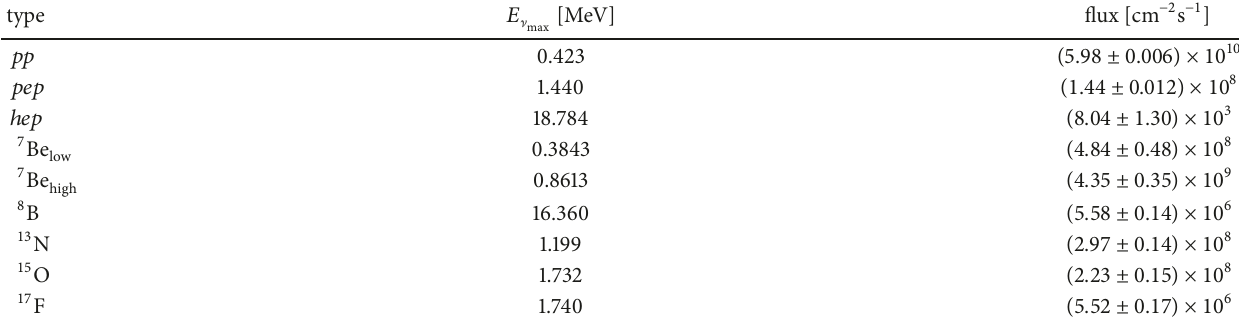
Table 1: Solar neutrino fluxes and uncertainties in the framework of the employed high metallicity SSM (for details, see the